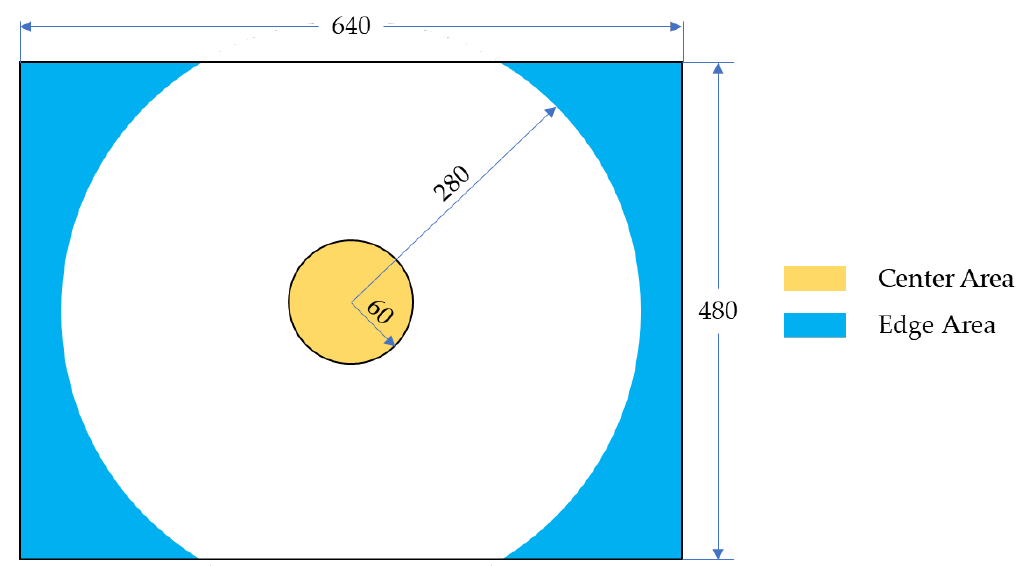
Figure 9. Illustration of the center and edge area; all values are in pixel units.